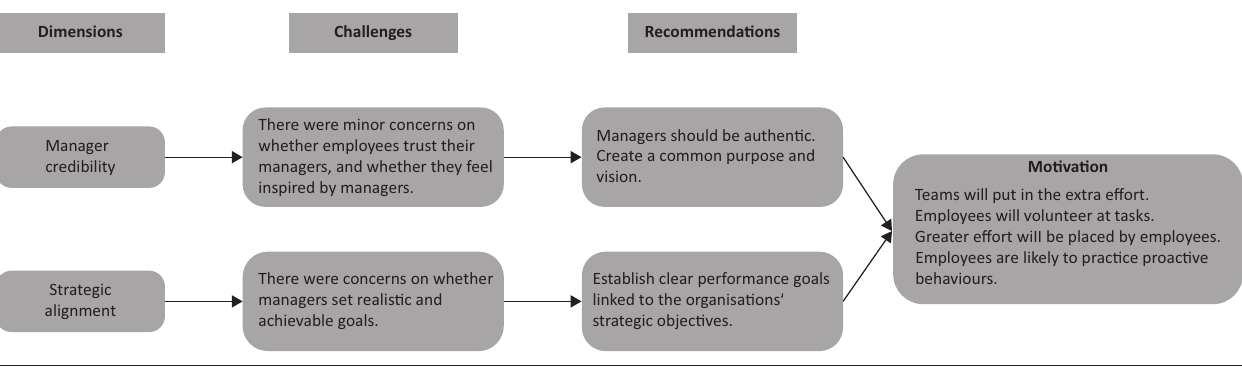
FIGURE 2: Recommendations based on manager credibility and strategic alignment on